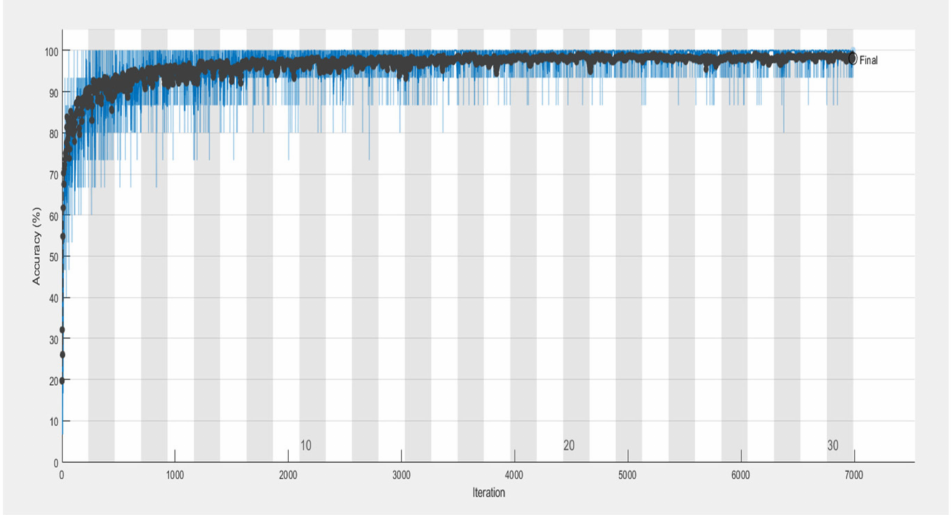
Figure 13. Accuracy of Alex Net